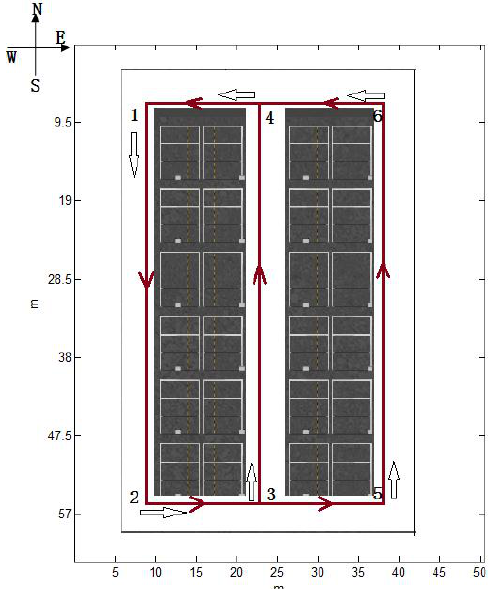
Figure 3. The map of the parking garage at the Beijing New Technology Base of the Chinese Academy of Sciences.